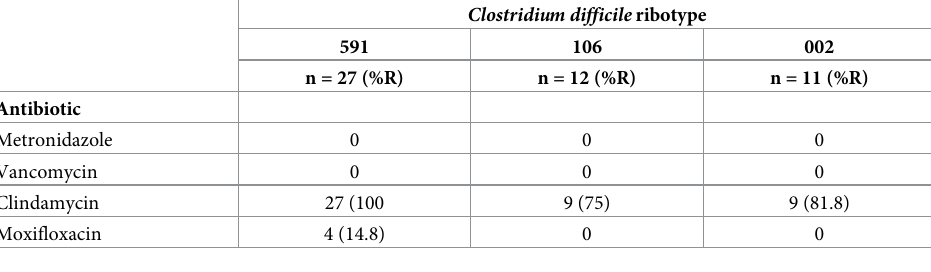
Table 2. Antibiotic resistance profile of C. difficile strains of ribotypes 591, 106 and